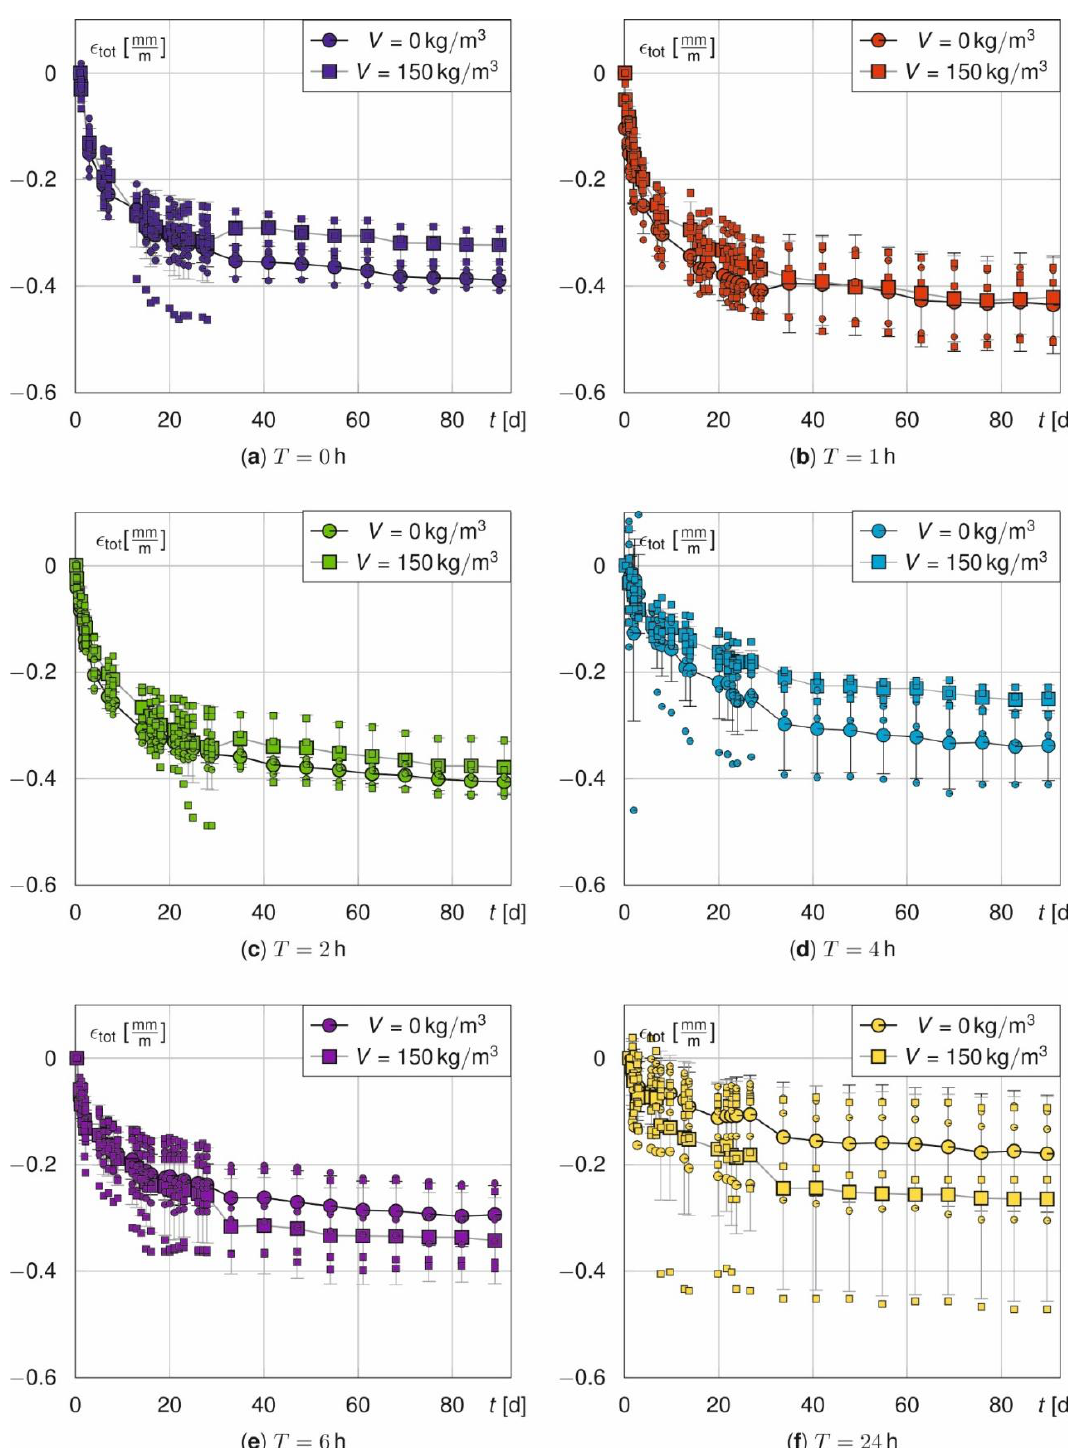
Figure 5. Total strain ε tot of the prisms as a function of fibre amount V for T = 0 h ( a ), T = 1 h ( b ), T = 2 h ( c ), T = 4 h ( d ), T = 6 h ( e ) and T = 24 h ( f ).